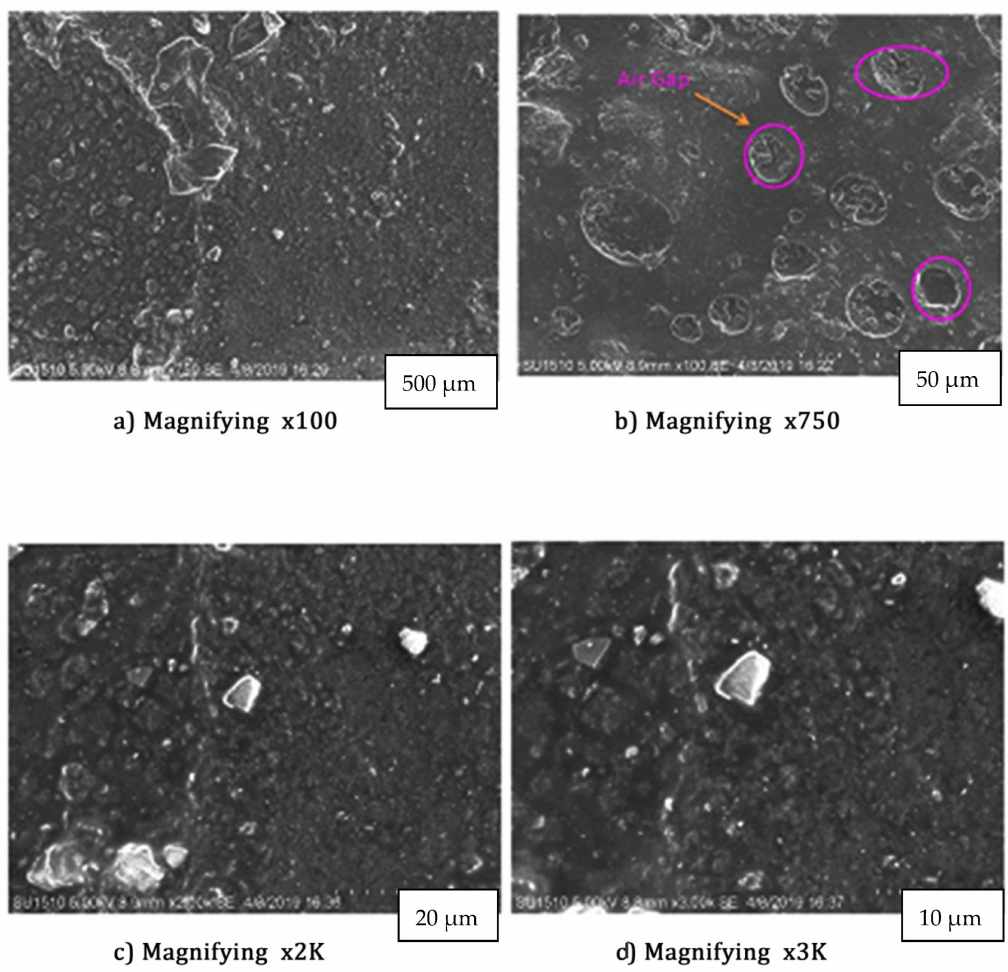
Figure 5. SEM photograph of green tea bioplastic at ( a ) 100 × , ( b ) 750 × , ( c ) 2000 × and ( d ) 3000 ×